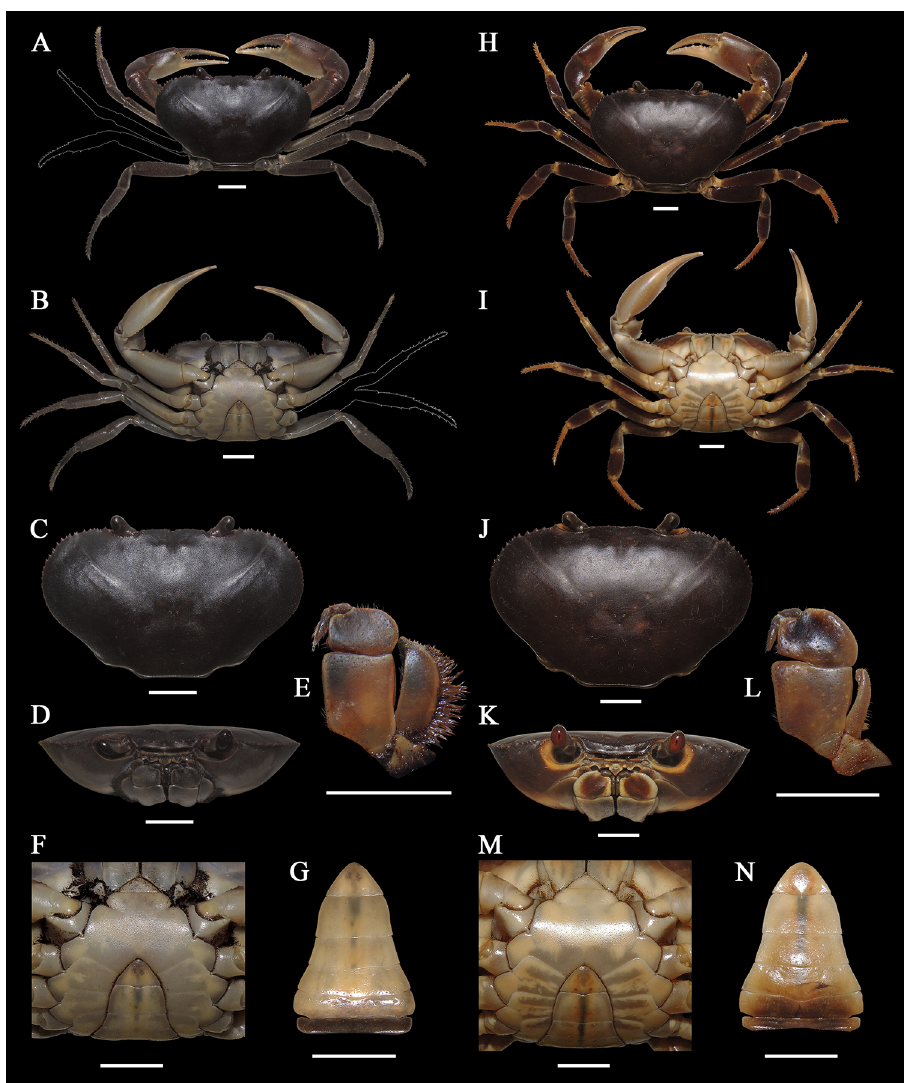
Figure 4. Adult male Epilobocera capolongoi (CZACC 5.0047) ( A – G ) and adult male E. cubensis (CZACC 5.0050) ( H – N ) from Lomas de Banao Ecological Reserve. A , H , Habitus, dorsal view; B , I , habitus, ventral view; C , J , carapace, dorsal view; D , K , carapace, frontal view; E , L , third maxilliped; F , M , sternal surface; G , N , pleon. All the images were taken soon after death (keeping the coloration in life), except E and L (after preservation). The white outline in A and B represent the missing second and third left walking legs. Scale bars = 10